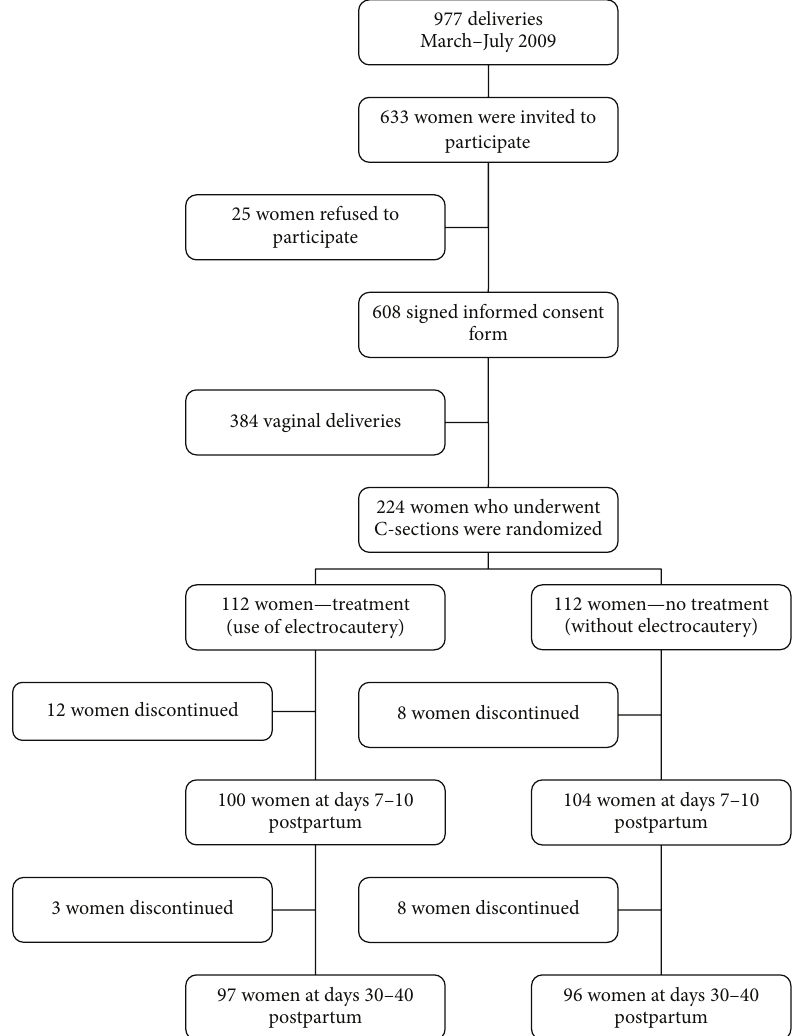
Figure 1: Flow chart of admission to and exclusion from the study.